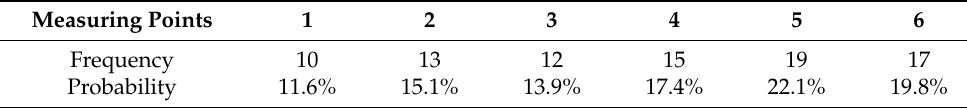
Table 6. Distribution of high temperature at different positions. Measuring